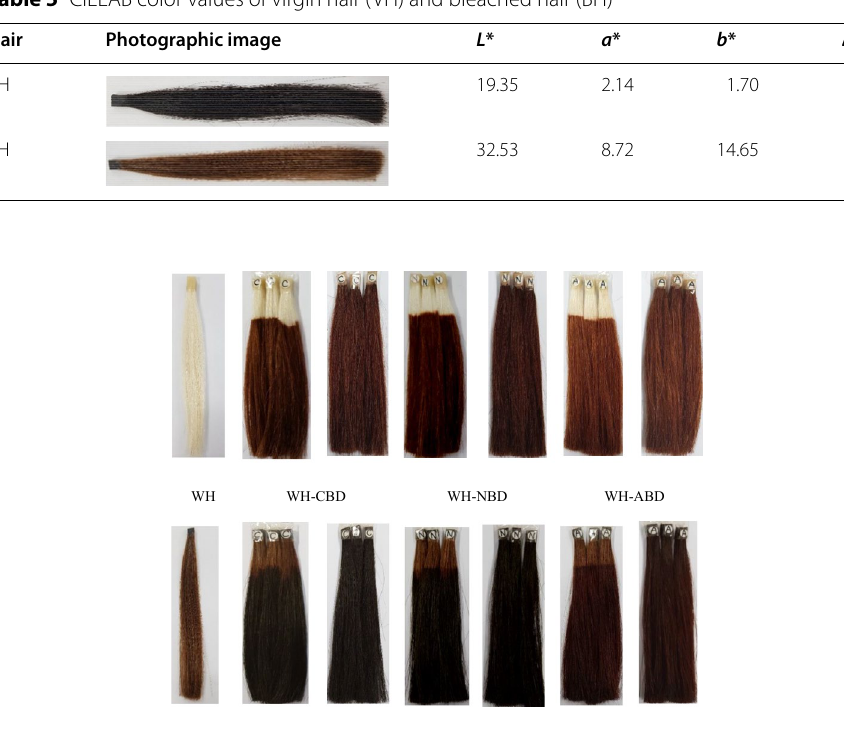
value represents green (-) to red ( ) color, and b * value represents blue ( + color (ISO/CIE, 2019). The and sign denote the direction, and the number denotes the + − magnitude of the corresponding color (ISO/CIE, 2019). The color difference (Δ E * ab ) was calculated using the CIELAB color difference equation (Eq. 1), where L * 0 , a * 0 , b * 0 were the color values of the reference and L * 1 , a * 1 , b * 1 were the color values of the corresponding sample (ISO/CIE, 2019). Here, the reference was VH and the sample was BH.